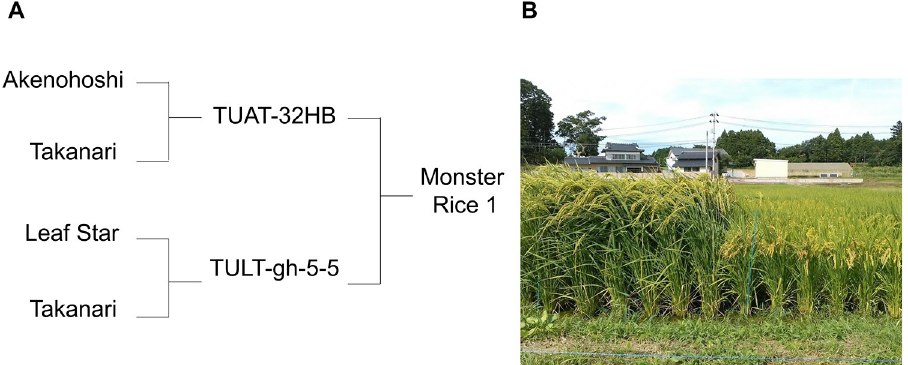
Fig 1. The pedigree chart and canopy of Monster Rice 1. (A) The pedigree chart of Monster Rice 1. (B) Left canopy is Monster Rice 1 and right canopy is Fukuhibiki, which is a high-yielding rice variety in Fukushima, Japan.